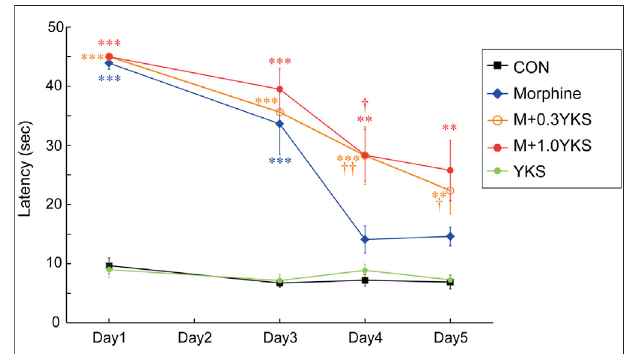
FIGURE 2 | Inhibitory effect of YKS on the development of morphine tolerance in the hot plate test. Morphine tolerance became pronounced on Day 4. YKS signi fi cantly suppressed the morphine tolerance at both doses, 0.3 and 1.0 g/kg/day. Values are the mean ± SEM ( n = 7 – 9) ** p <